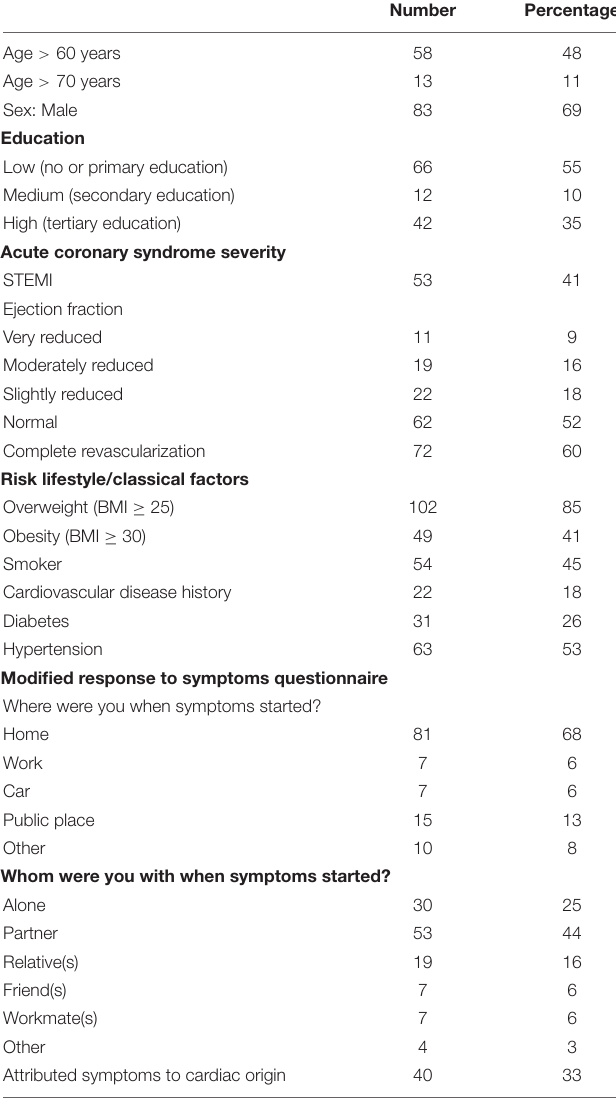
TABLE 1 | Demographic and clinical characteristics of the sample (categorical